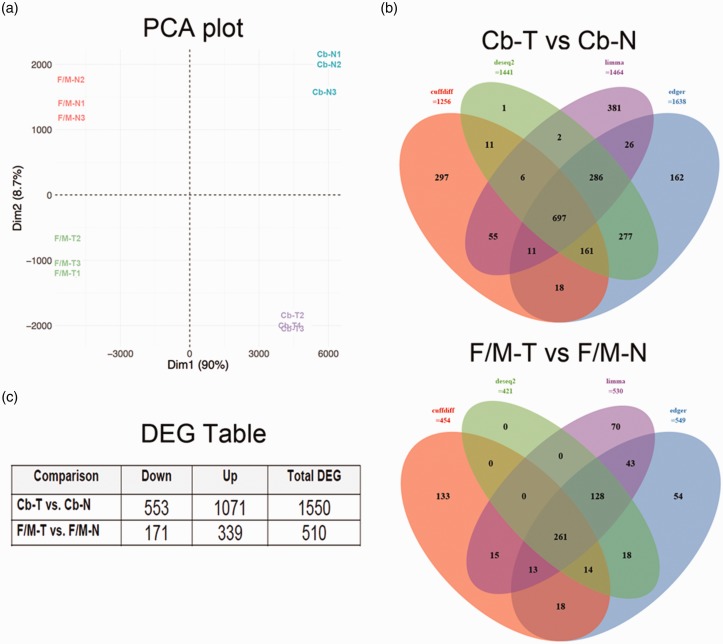
Statistical determination of DEG. (a) PCA plot of all samples based on
normalized expressions. Control forebrain/midbrain (F/M-N),
Tpp1–/– forebrain/midbrain (F/M-T), control cerebellum (Cb-N), and
Tpp1–/– cerebellum (Cb-T) of triplicate samples are represented. (b)
Venn diagram of differentially expressed mRNA genes identified by four
different methods: Cuffdiff, edgeR, DESeq2, and limma. Only genes
identified by at least two methods were used for further analysis. (c)
Number of up-/downregulated DEG in different comparison(s).PCA = principal component analysis; DEG = differentially expressed
genes.